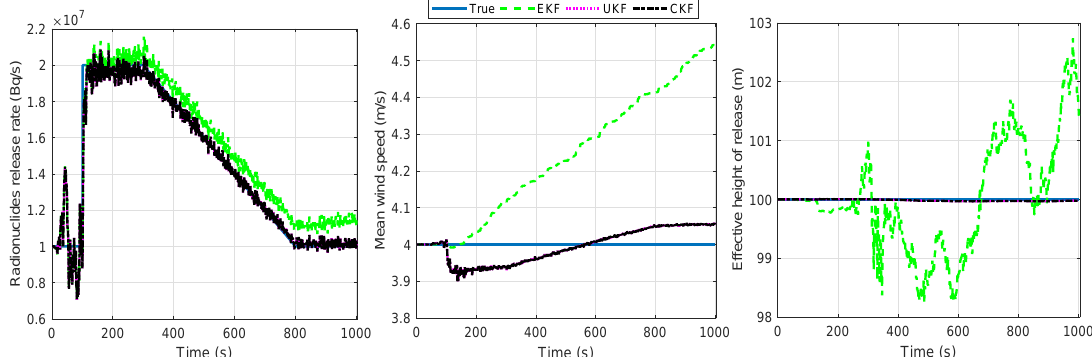
Figure 3. True and estimated release rate, wind speed, and height of release for variation in release